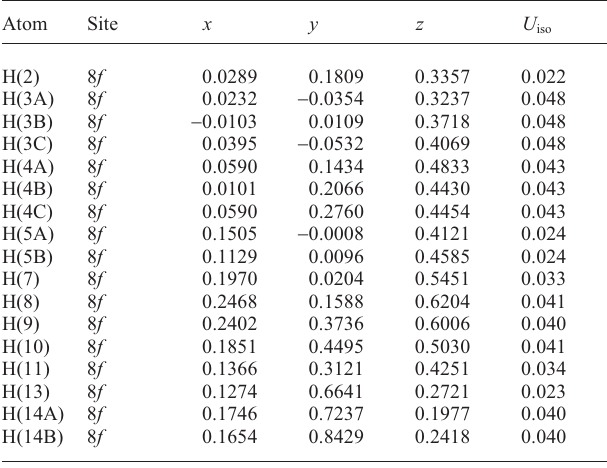
Table 2. Atomic coordinates and displacement parameters (in Å 2 )